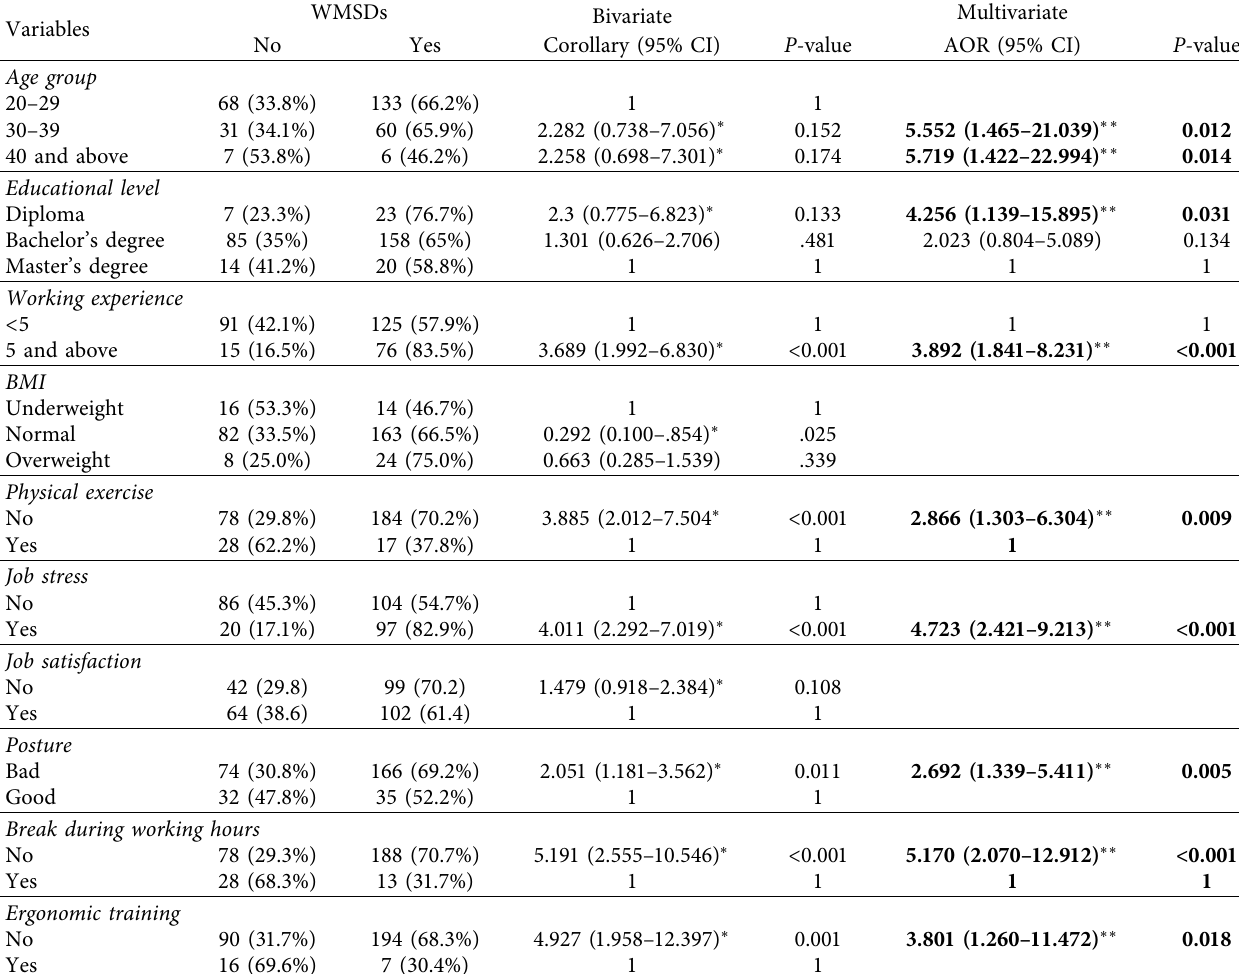
Table 4: Bivariate and multivariate logistic regression analysis of associated factors with WMSDs among bankers working in Mekelle city, Tigray, Ethiopia, May 2018 ( n �